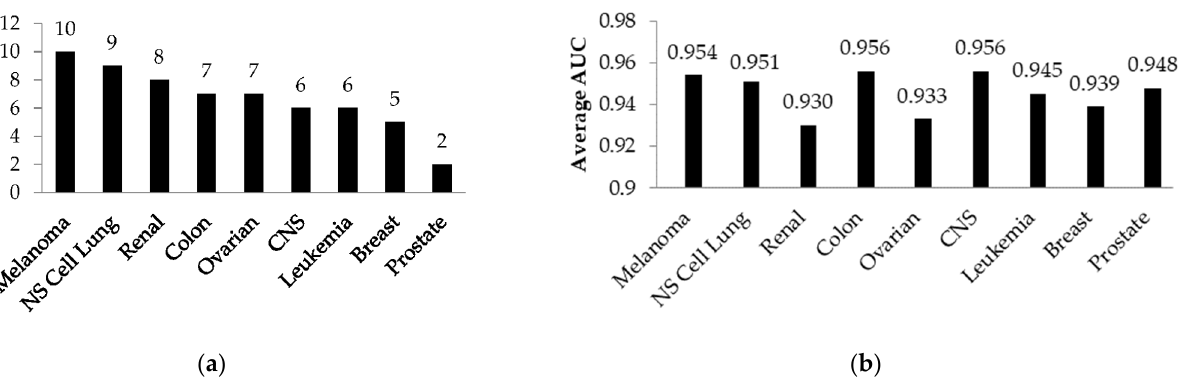
Figure 2. ( a ) Distribution of cell lines from DTP NCI60 by organs or general types; ( b ) average accuracy of cytotoxicity prediction for grouped cell lines from DTP NCI60 at a 1 nM IG 50 value threshold. NS Cell Lung—nonsmall-cell lung.